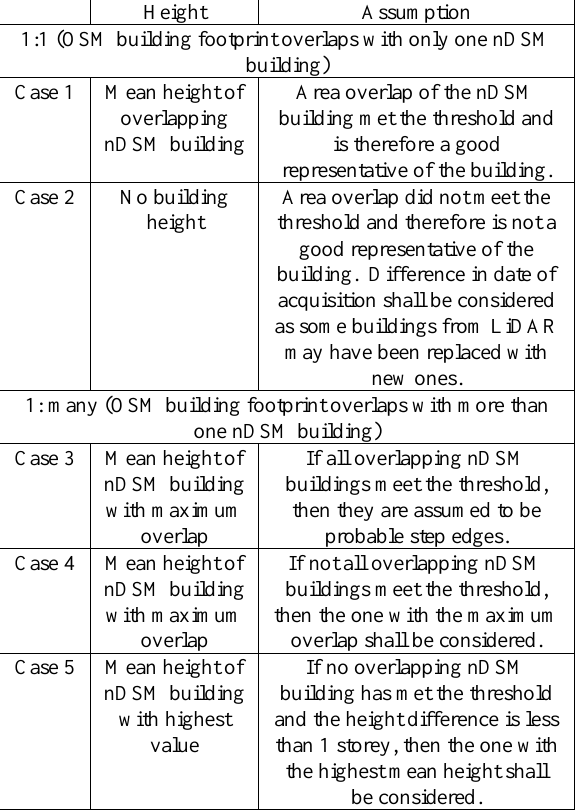
Table 1. The decision tree classifier for building height extraction.